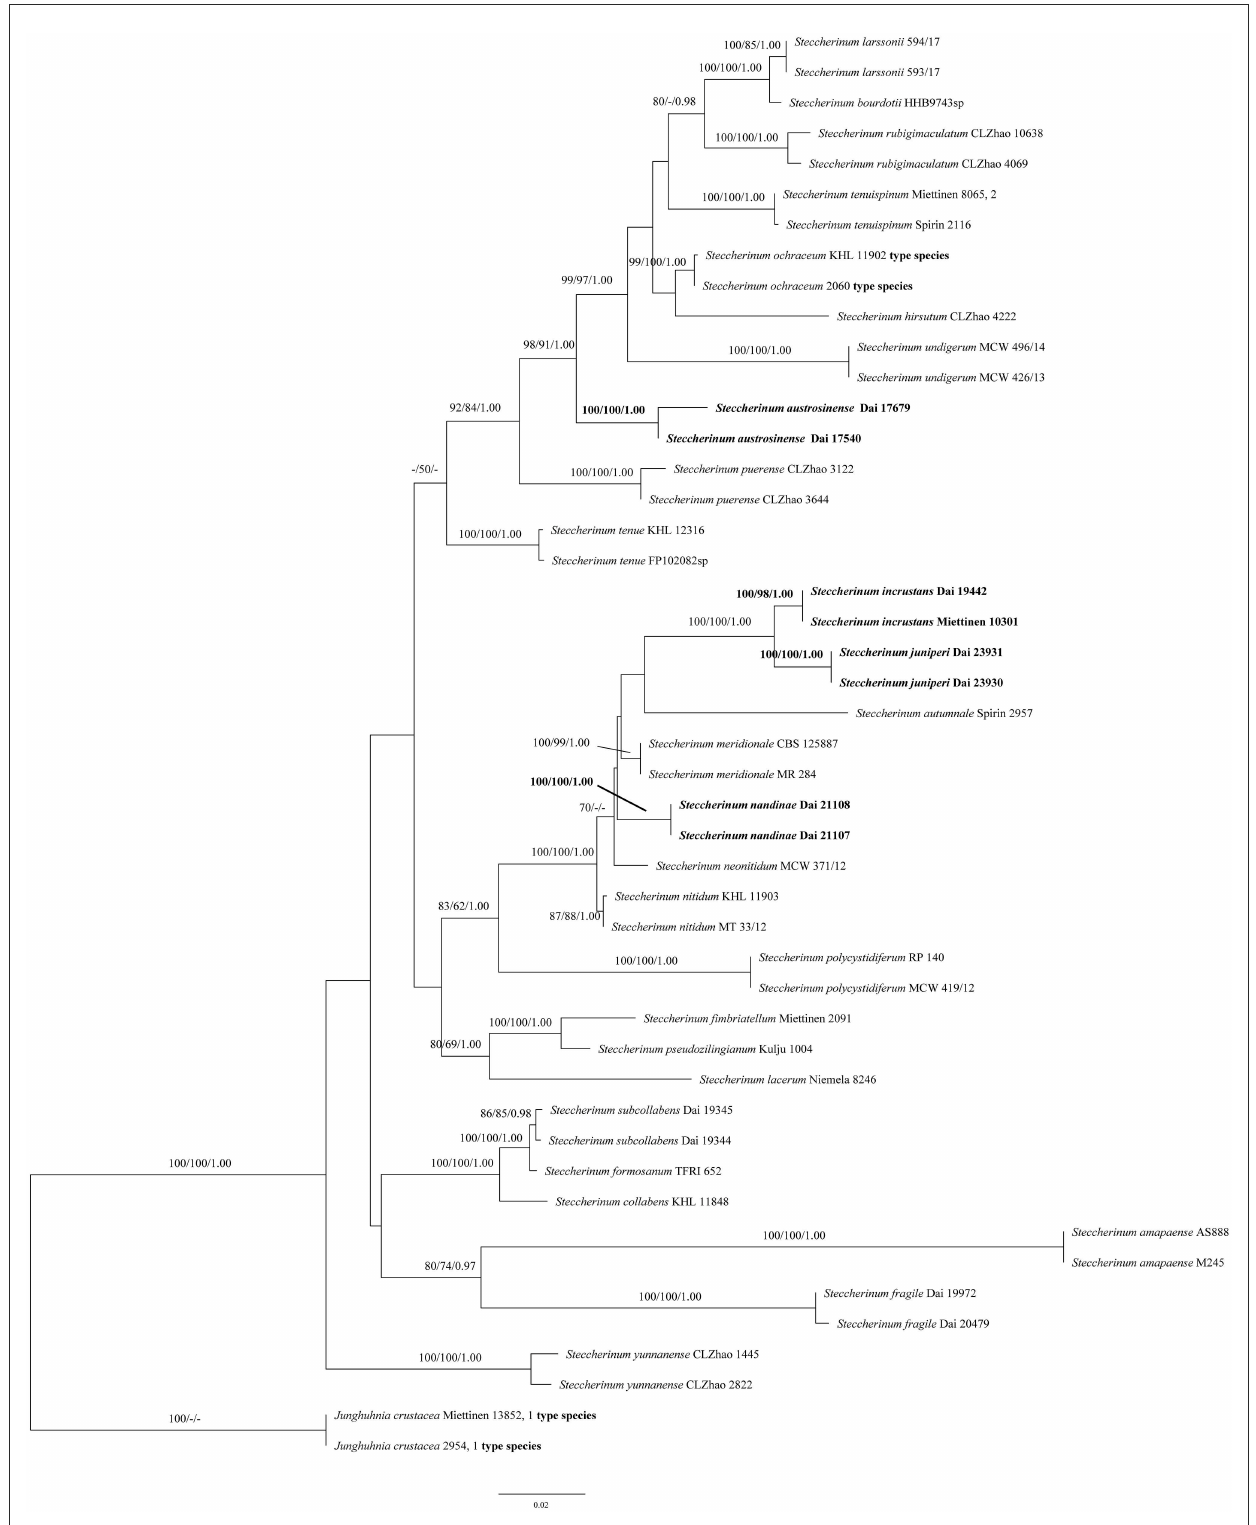
FIGURE1 Phylogeny of Steccherinum generated by maximum likelihood (ML) analysis based on combined ITS and nLSU rDNA sequences. Branches are labeled with ML bootstrap > 70%, maximum parsimony bootstrap > 50%, and Bayesian posterior probabilities > 0.95, respectively. New species and new combinations are in